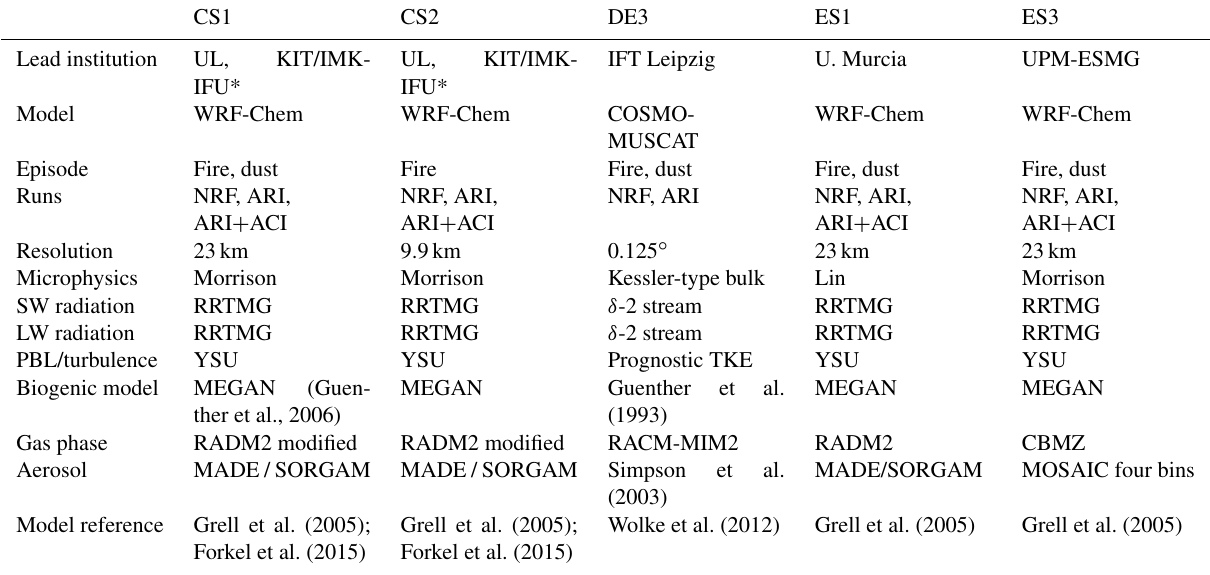
Table 1. Modeling systems participating and their contributions to the case studies. CS1 CS2 DE3 ES3 Lead institution